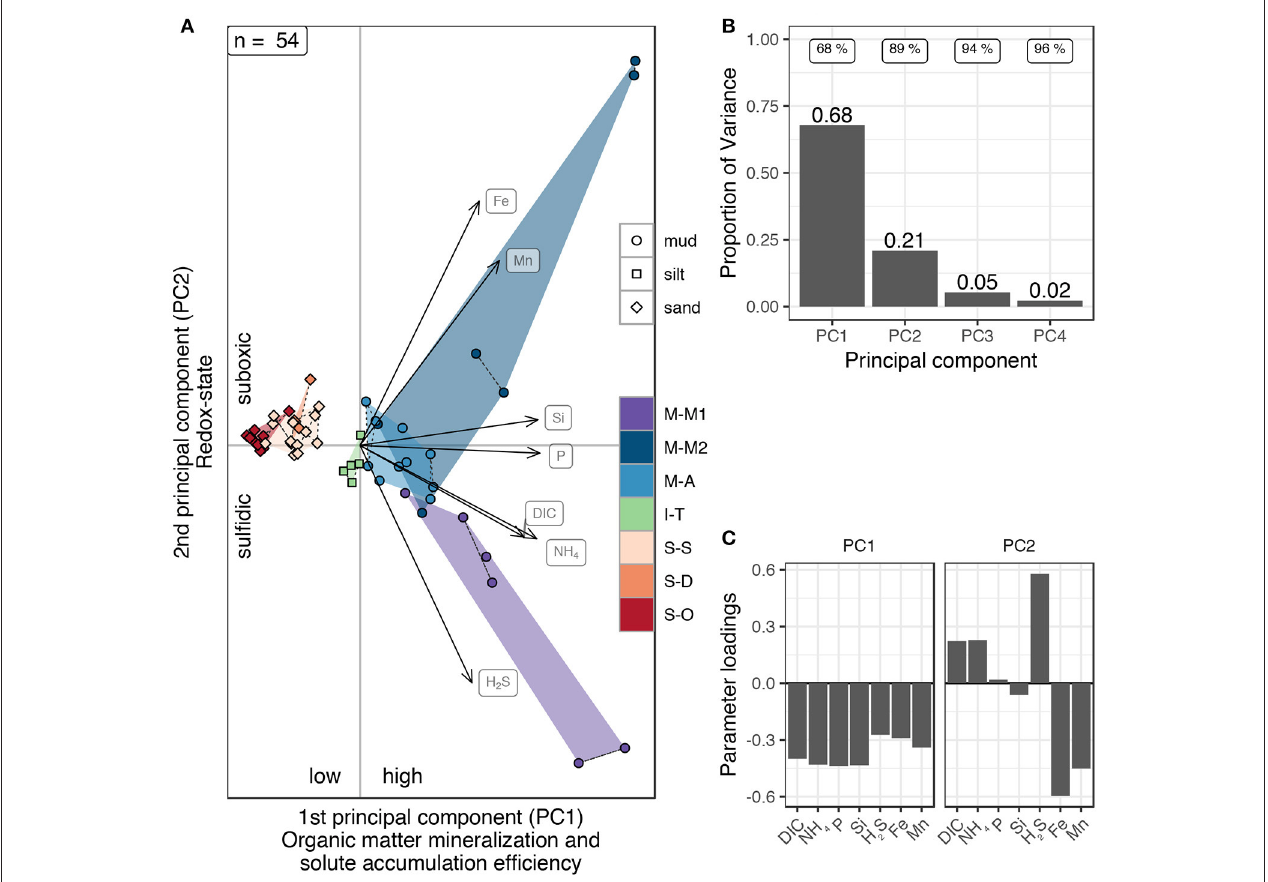
FIGURE 8 | Principal component analysis (PCA) of southern Baltic Sea benthic solute reservoirs in the top 10 cm. (A) Each dot represents the mean benthic solute reservoir of DIC , NH + 4 , PO 4 , H 4 SiO 4 , sulfide, Fe 2 + , and Mn 2 + from parallel cores of each sampling campaign. Shaded areas envelop the expansion of variability of each study site in the two-dimensional space. Dashed lines connect points of the same sampling time. (B) Explained variance by different principal components. The first principal component alone explains 68 % and cumulative proportions of the first two principal components explain 89 % of the total variance. (C) Loadings of the major two components of the principal component analysis. All considered parameters substantially contribute to PC1. PC2 is loaded with the redox sensitive parameters dissolved sulfide ( H 2 S ), Fe 2 + , and Mn 2 + (note the anticorrelation between H 2 S and dissolved metals Fe 2 + and Mn 2 + ) with minor contributions of DIC and NH